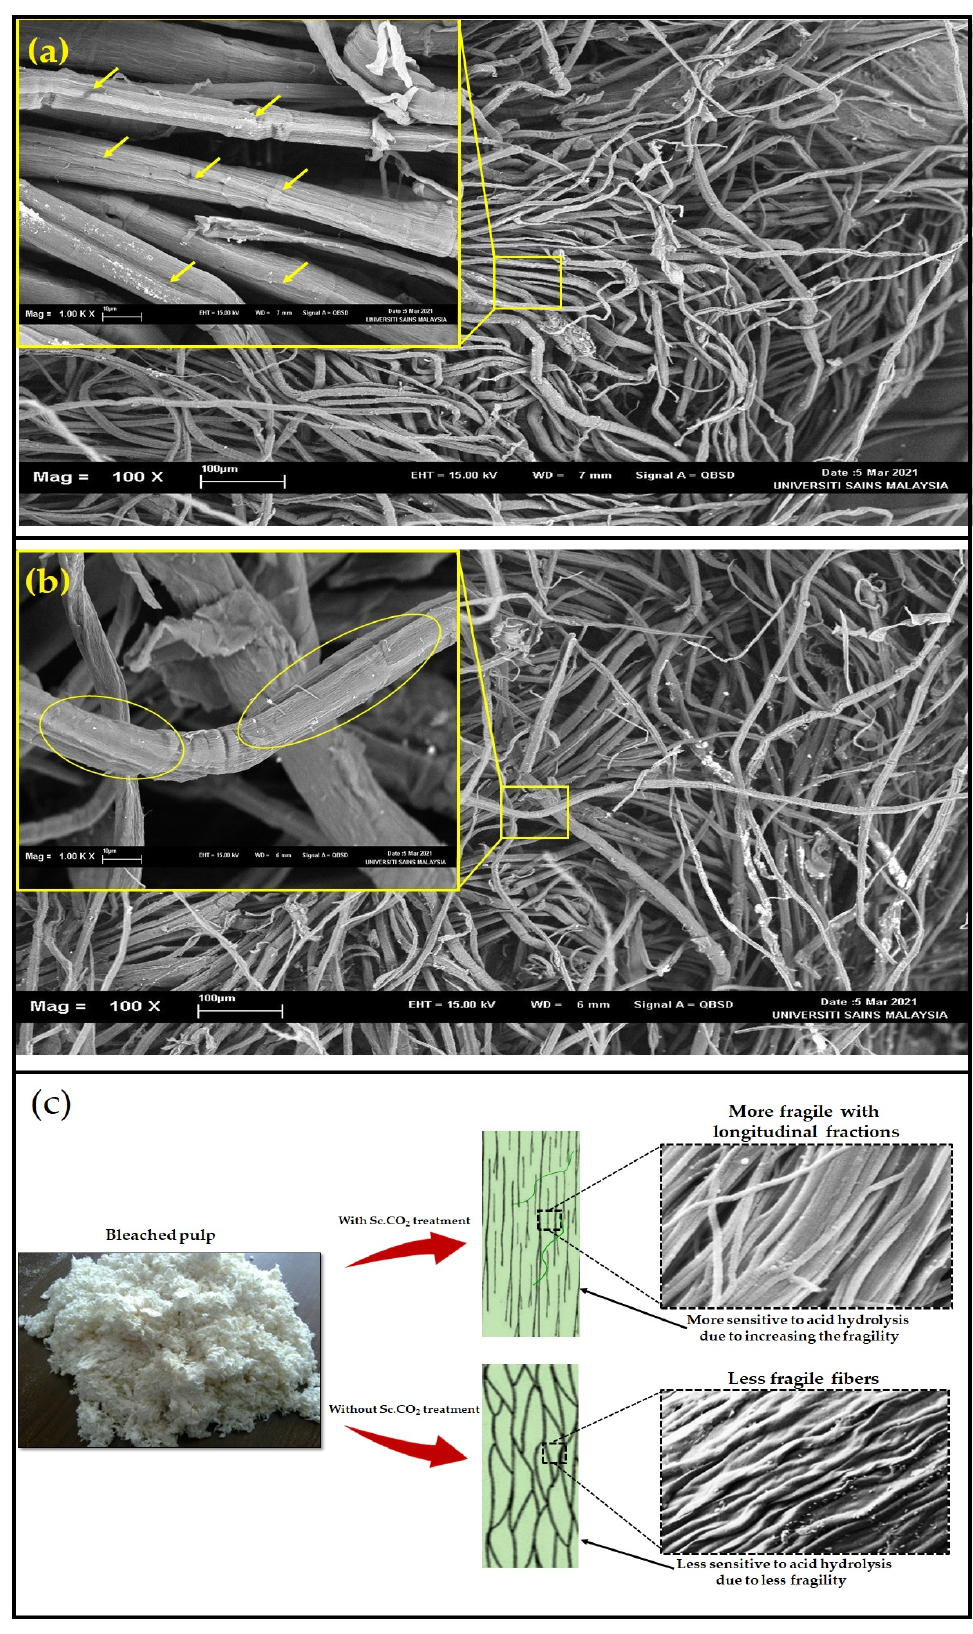
Figure 2. SEM images of bleached carpet pulp: ( a ) Sc.CO 2 treated fibers, ( b ) untreated bleached fibers, and ( c ) schematic drawing of the possible supercritical fraction mechanism on the carpet